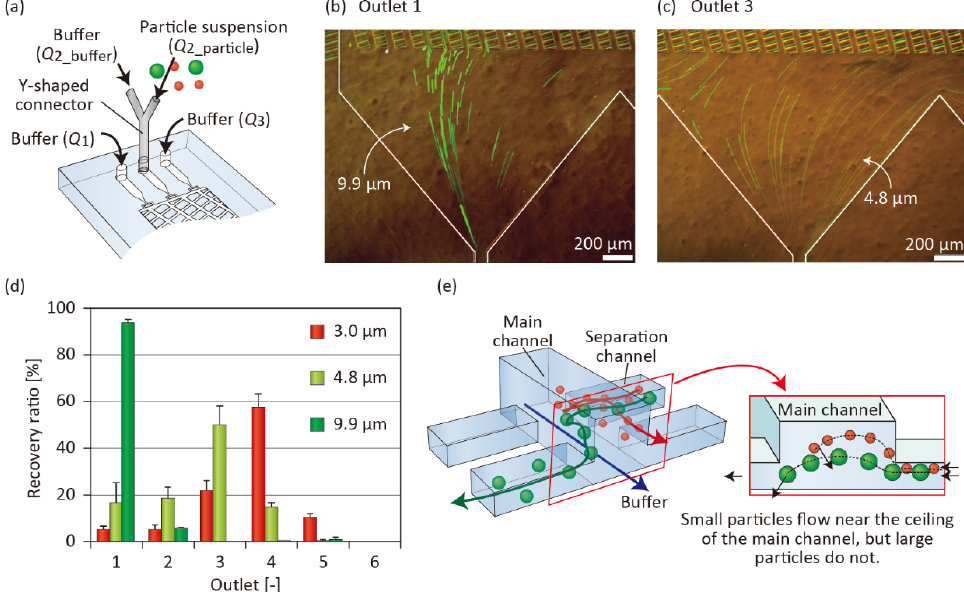
Figure 8. ( a ) Schematic image showing Microdevice A with an attached Y-shaped connector. ( b,c ) 4.8- and 9.9- μ m particles flowing near Outlets 1 and 3. ( d ) Result of particle separation when Q 1 , Q 2_particles , Q 2_buffer , and Q 3 were 20, 2, 18, and 80 μ L/min, respectively. Each set of data represents the mean ± SD from three individual experiments. ( e ) Schematic image showing the particle behaviors in the lattice channel, when the input position of the particles was restricted to the upper